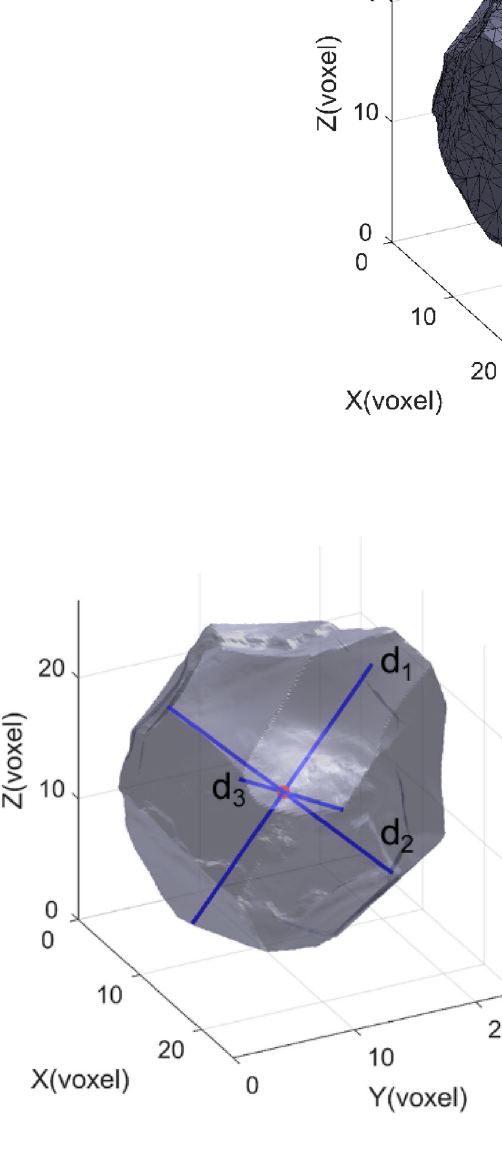
Fig. 5. 3D geometry repre- sentation and tetrahedral decomposition for volume computation